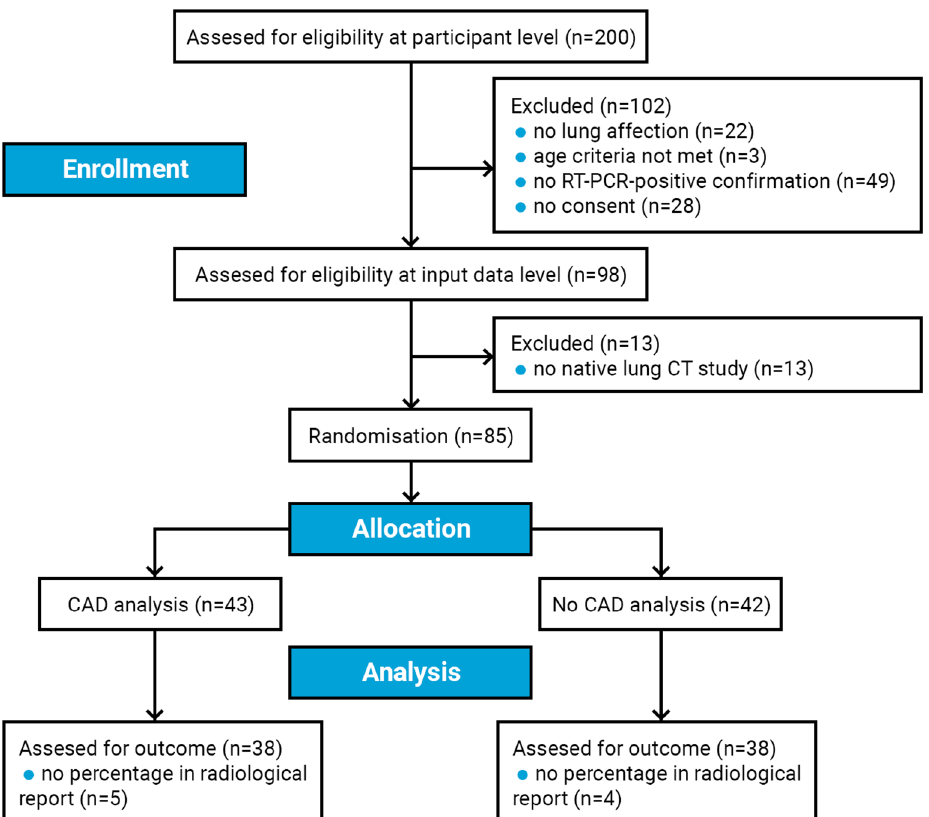
Figure 5. CONSORT-AI flow diagram describing the patient selection process.